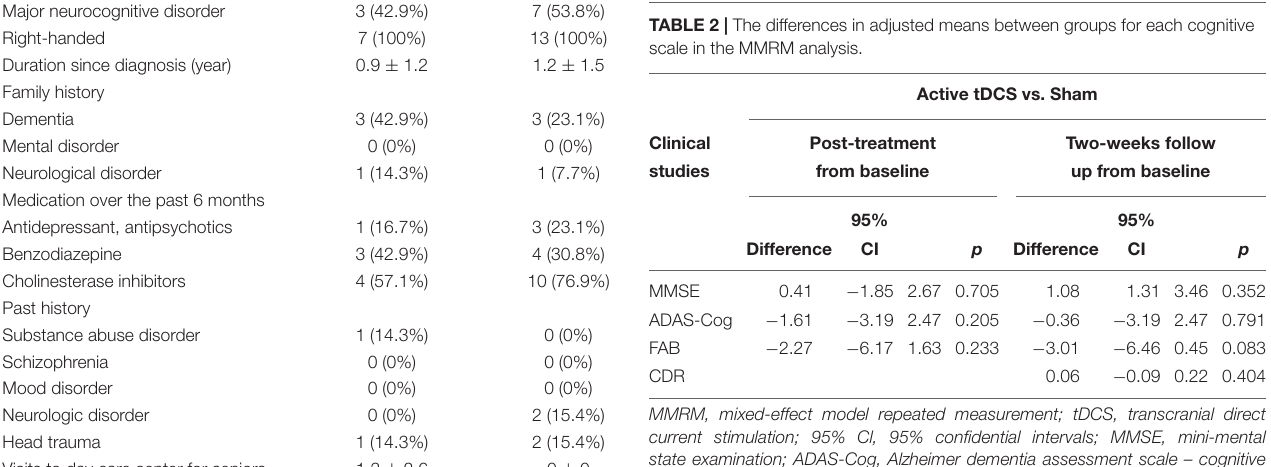
MMRM, mixed-effect model repeated measurement; tDCS, transcranial direct current stimulation; 95% Cl, 95% confidential intervals; MMSE, mini-mental state examination; ADAS-Cog, Alzheimer dementia assessment scale – cognitive subscale; FAB, frontal assessment battery; CDR-J, clinical dementia rating- Japanese